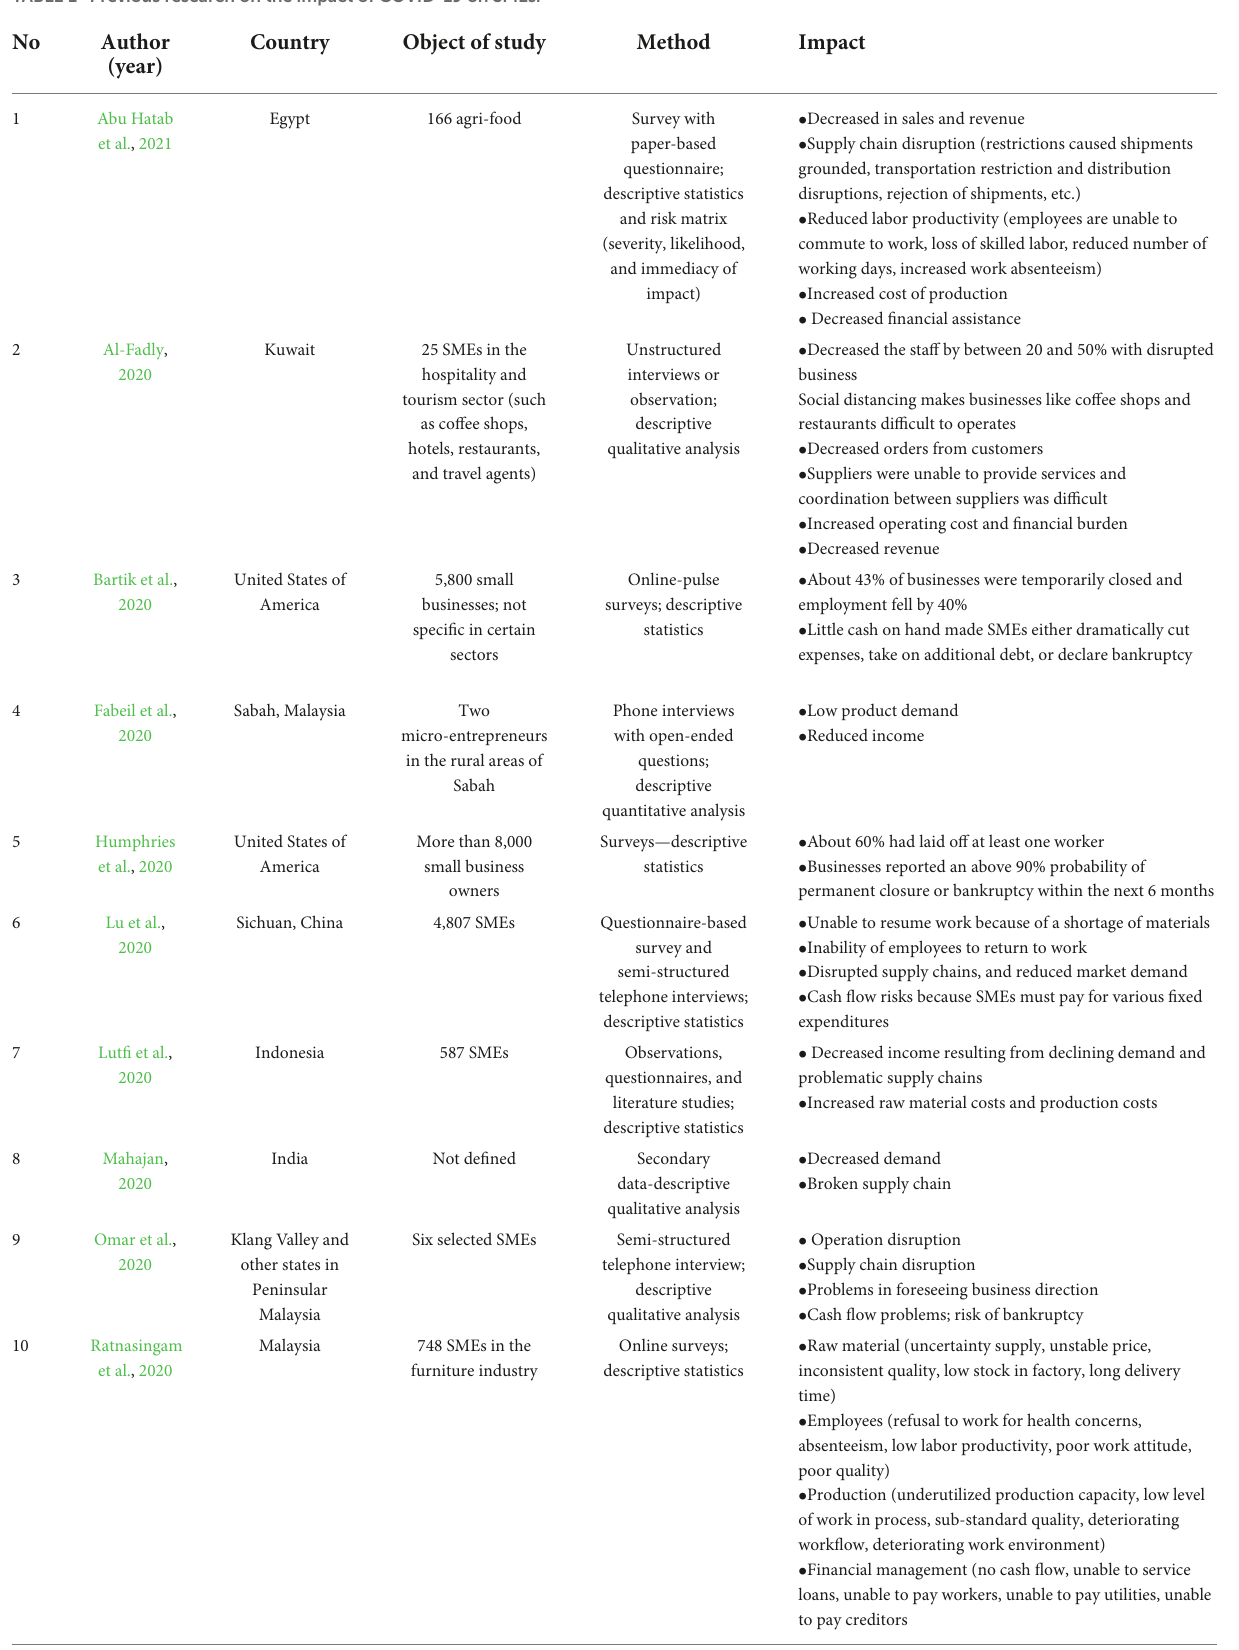
TABLE 1 Previous research on the impact of COVID-19 on